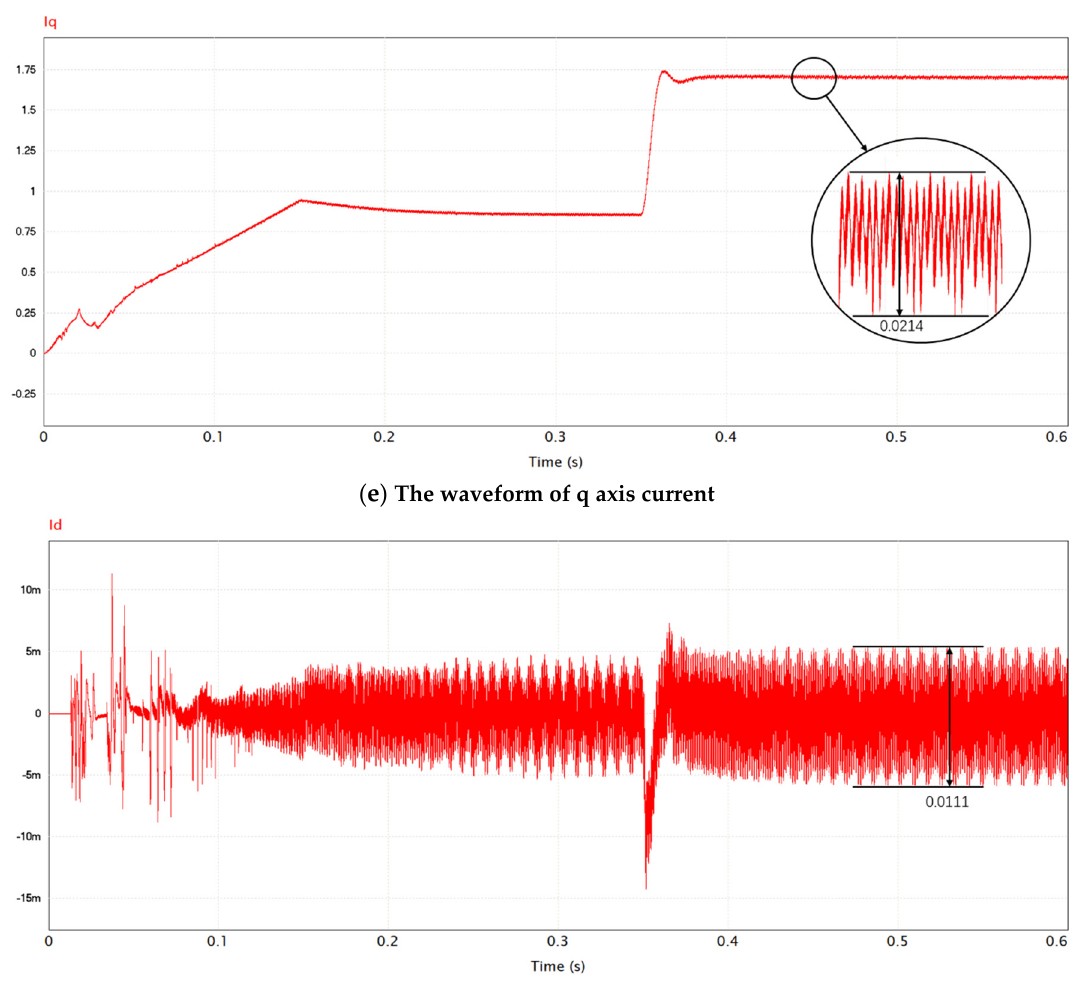
Figure 12. Simulation result of adaptive RBFNN-SMC.